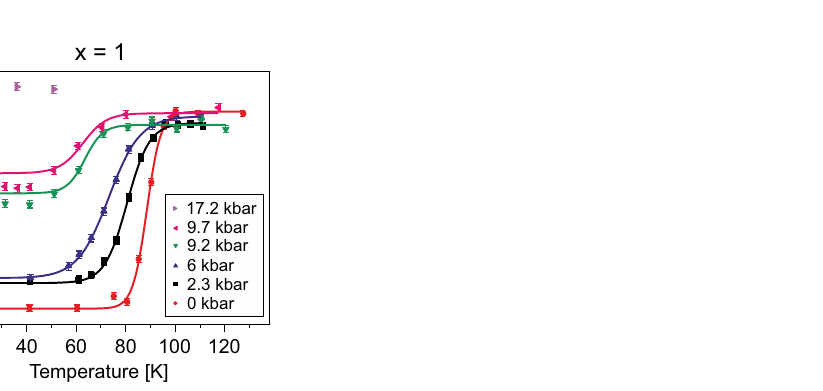
Figure 6. Temperature and pressure dependence of A TF for the x = 1 compound, obtained using Eq. (2). The solid lines are fits using the sigmoidal function, while the vertical shaded area indicate an approximative region for the transition temperature T i ≈ 20 K (see text and Fig. 7 for further details).